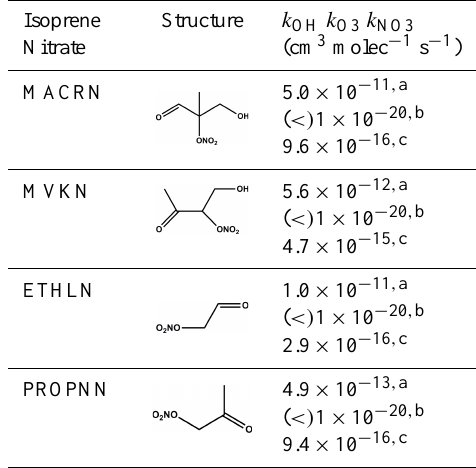
Table 3. Secondary isoprene nitrates and corresponding rate con- stants (units of cm 3 molec − 1 s − 1 )